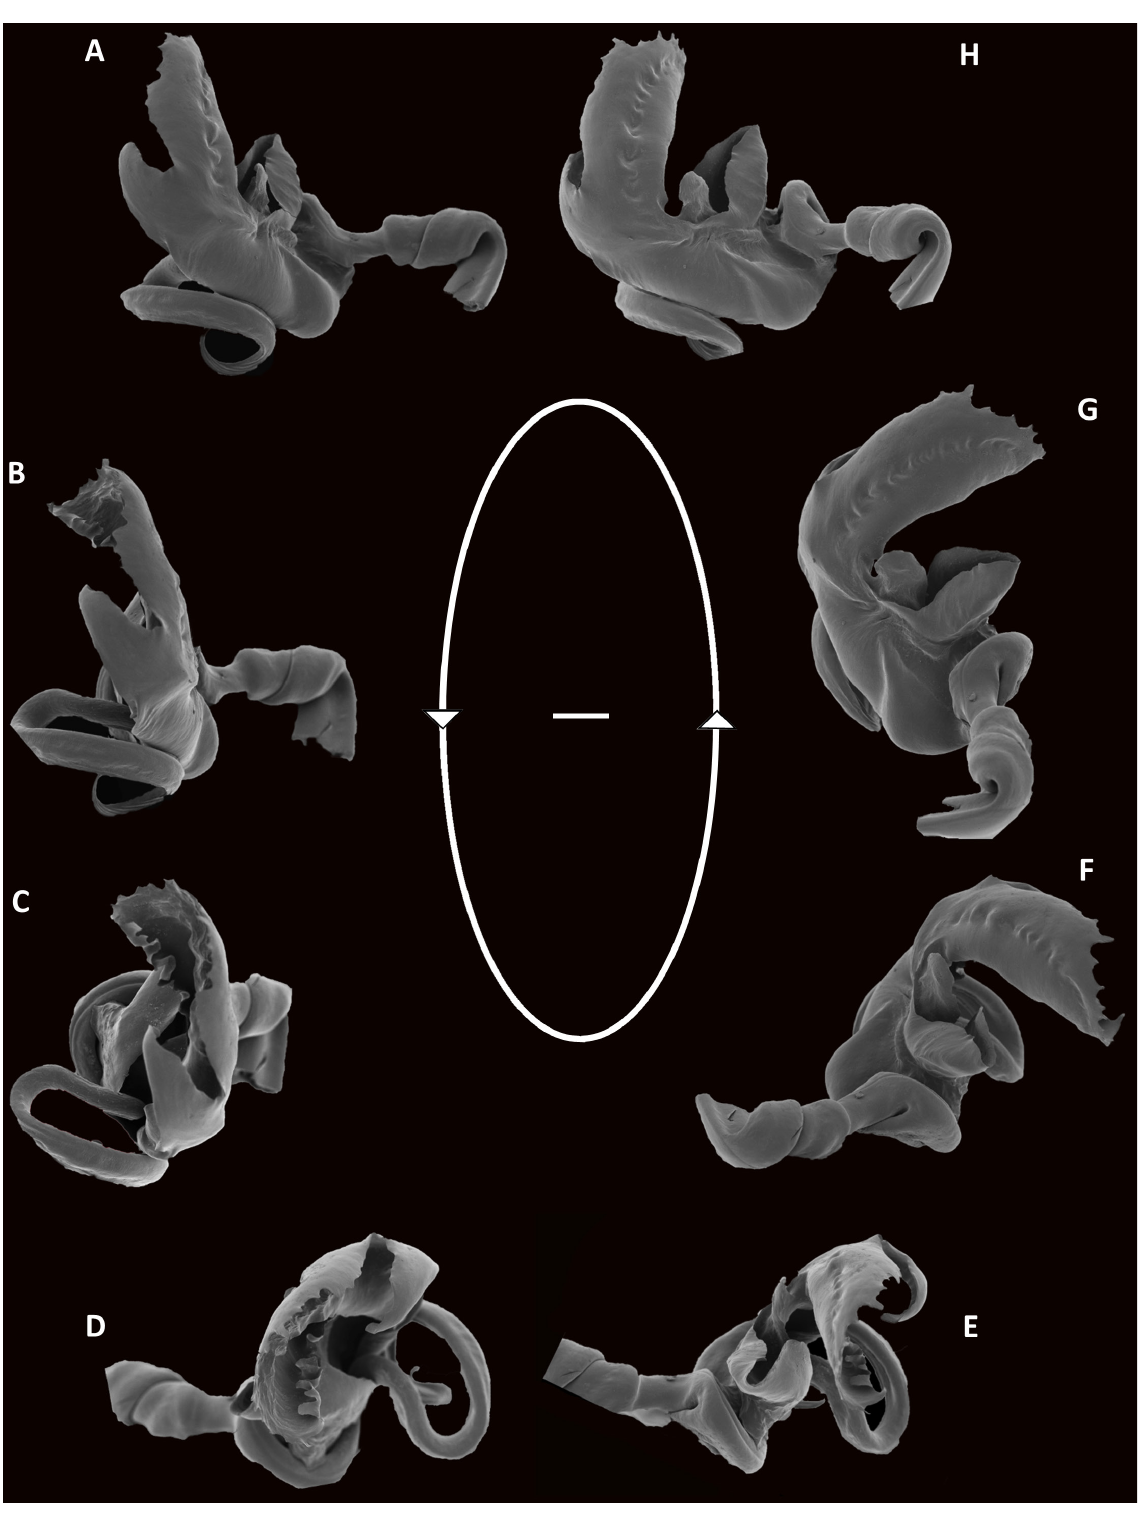
Fig. 28. Chaleponcus nesrineae sp. nov., holotype, ♂ (VMNH110628). Right gonopod telopodite, ‘360° tour’. A . Anterior view. B . Meso-anterior view. C . Mesal view. D . Meso-posterior view. E . Posterior view. F . Latero-posterior view. G . Lateral view. H . Latero-anterior view. Scale bar = 0.2